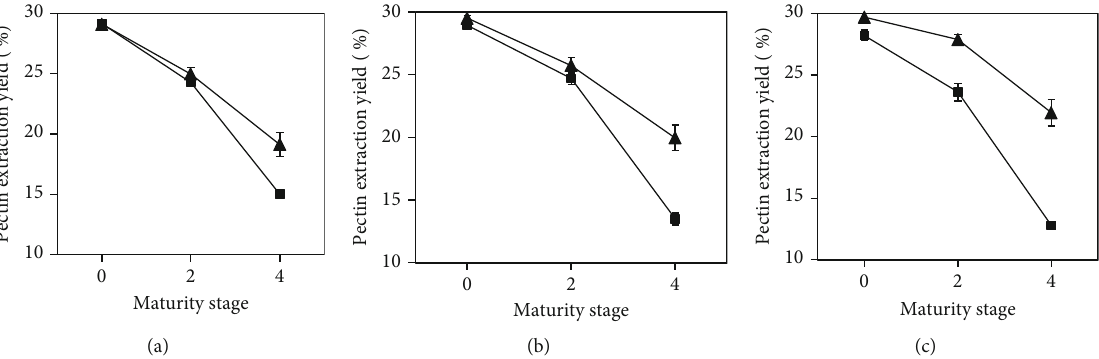
Figure 1: Pectin extraction yield from mango peel as function of maturity stage (0, 2, and 4) at 37 kHz ( ▲ ) and 80kHz ( ■ ): (a) 20 min, (b) 25min, and (c) 30 min.